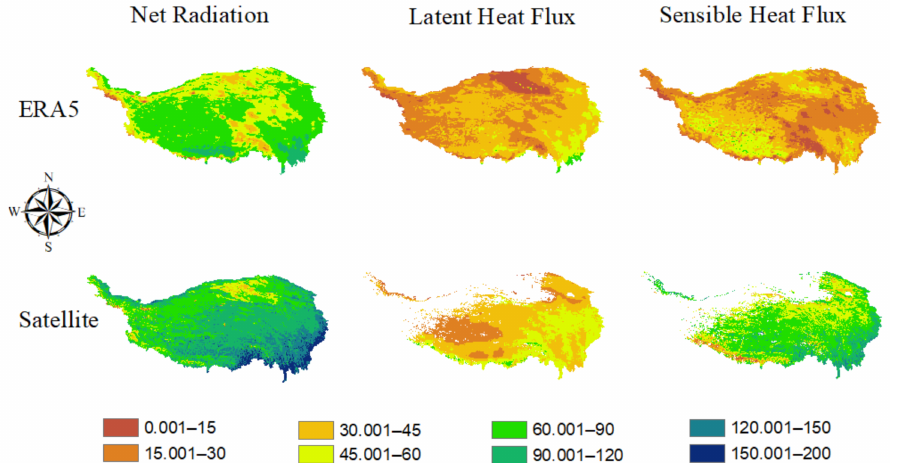
Figure 4. The spatial trend of RN, LE, and SH from ERA5 and satellite data. Spatial distribution image of each SEB parameter is produced by averaging 19 years mean annual spatial images of the corresponding data (study duration 2001–19). The unit of the legend is Wm − 2 . White regions in satellite LE and SH are the missing